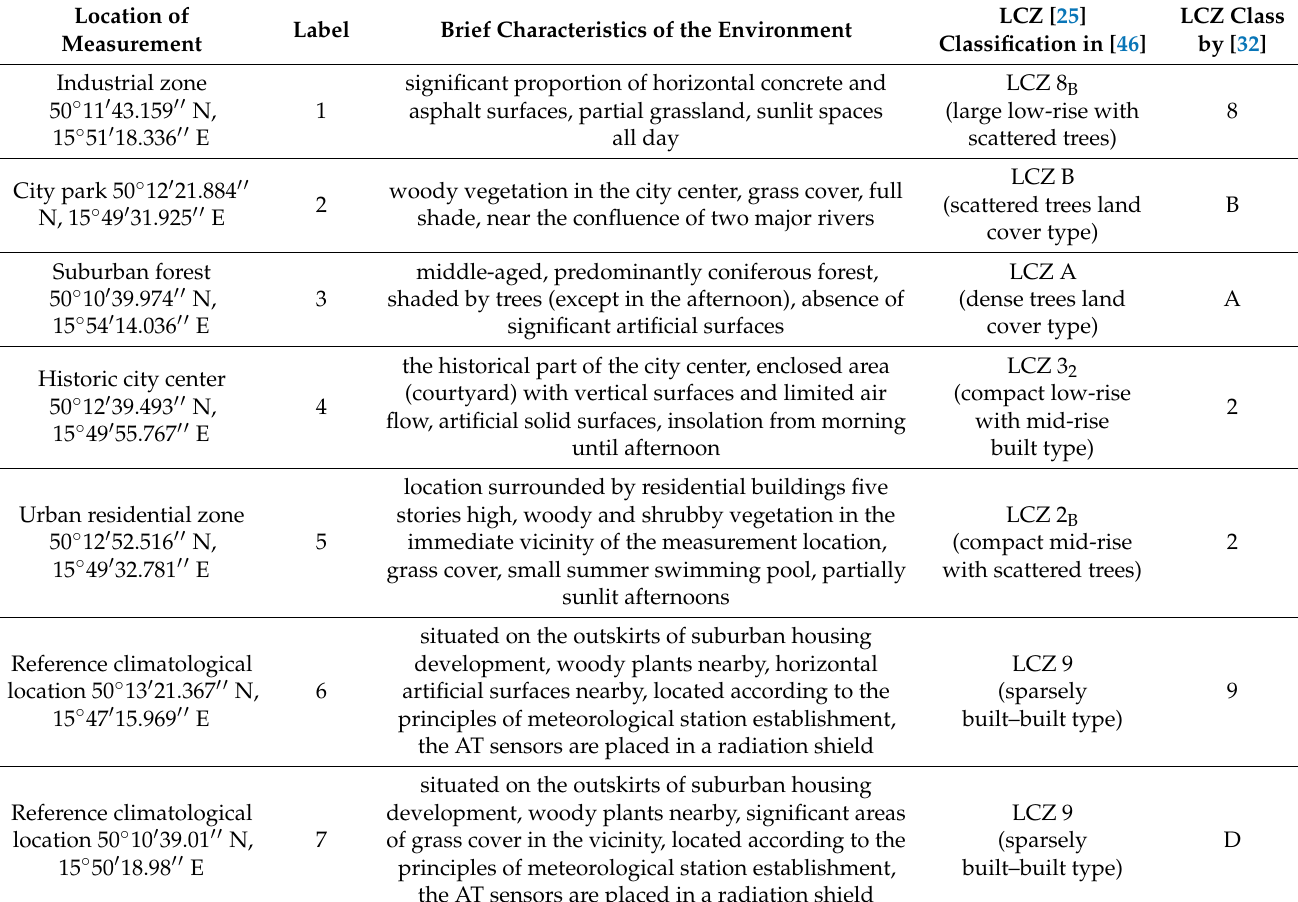
Table 3. Location of the measurement and characteristics of the